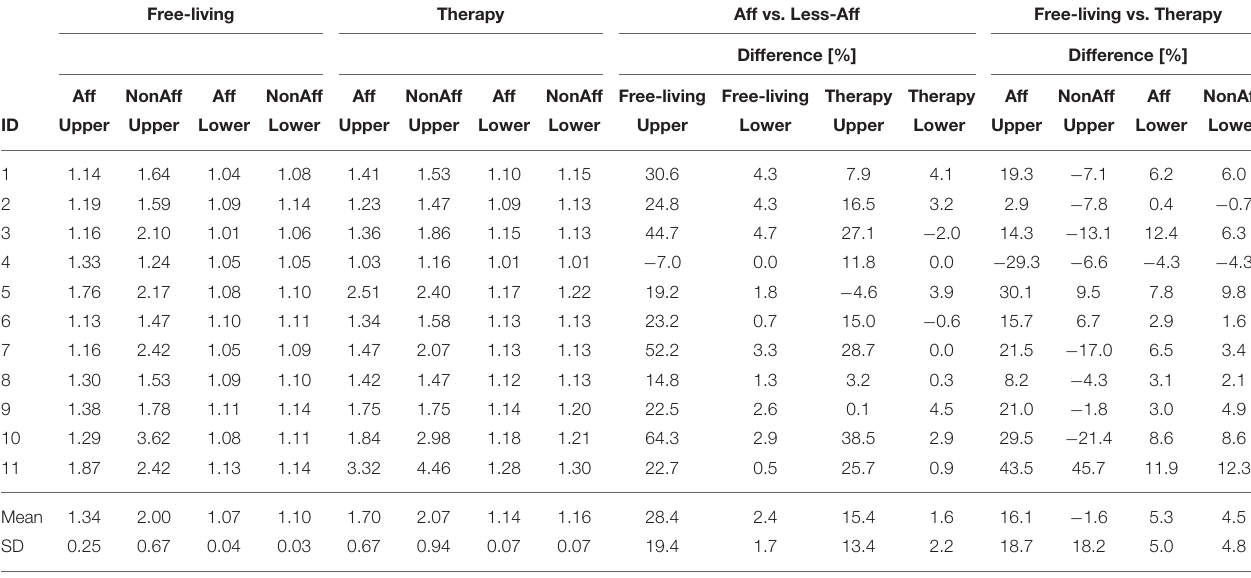
TABLE 2 | Average MET equivalents for affected and less-affected upper and lower body sides during free-living and therapy. Free-living Therapy Aff vs. Less-Aff Free-living vs. Therapy Difference [%] Difference [%] NonAff Free-living Free-living Therapy Therapy Aff NonAff